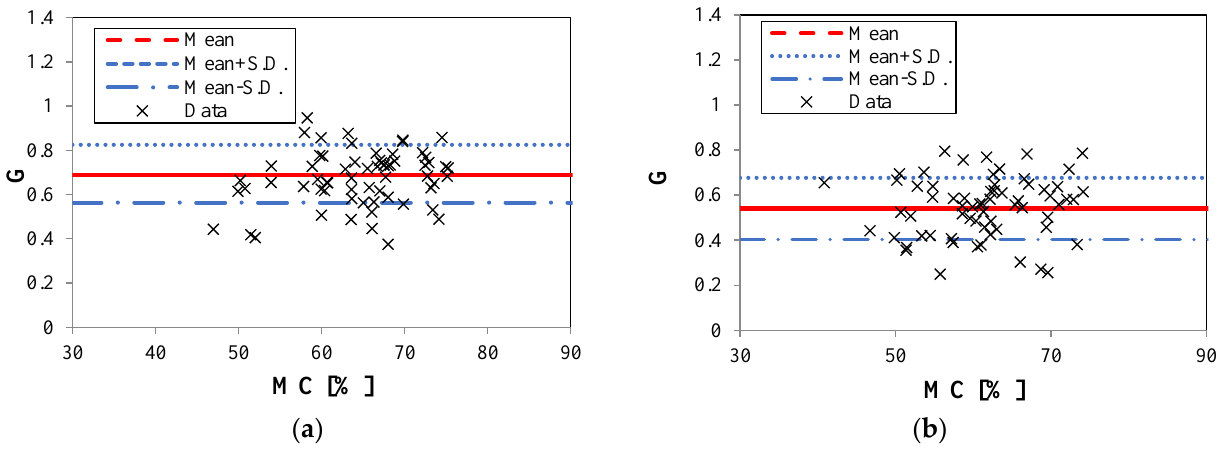
Figure 5. Moisture reduction factor (G) versus MC for Group I samples: ( a ) E. nitens ; ( b ) P. radiata. S.D. denotes standard deviations.